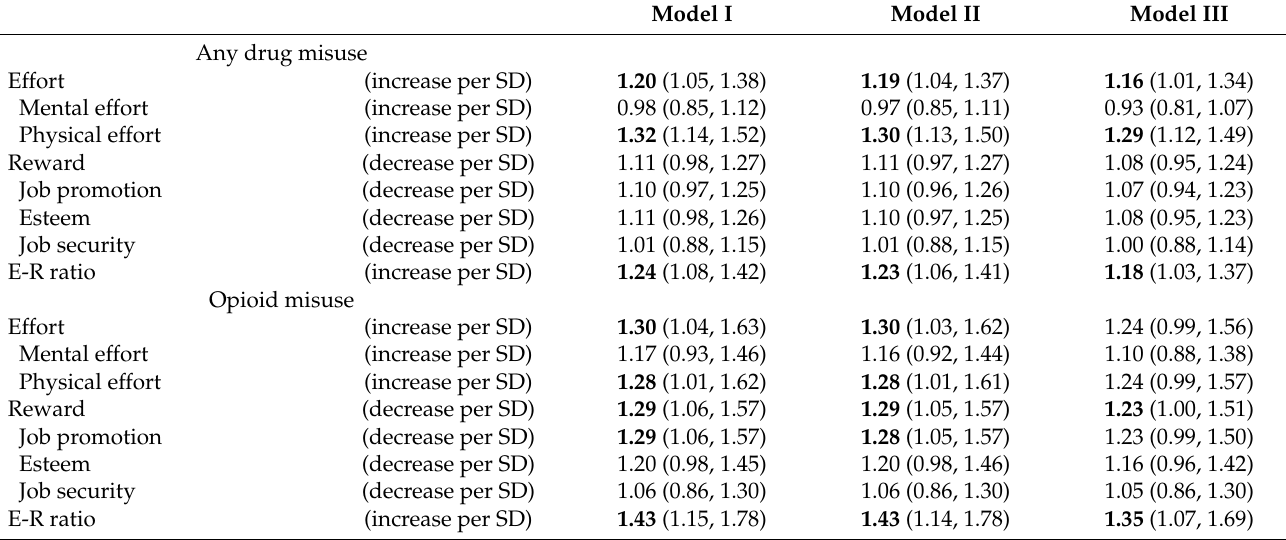
Table 3. Associations of effort–reward imbalance at work with drug misuse (odds ratios (ORs) and 95% confidence inter- vals